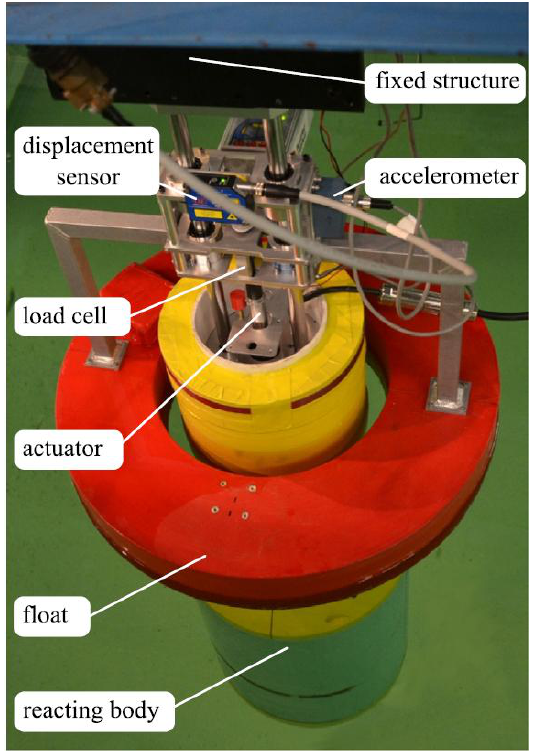
Figure 16. WAVEBOB floating in a wave tank with all the equipment [5]